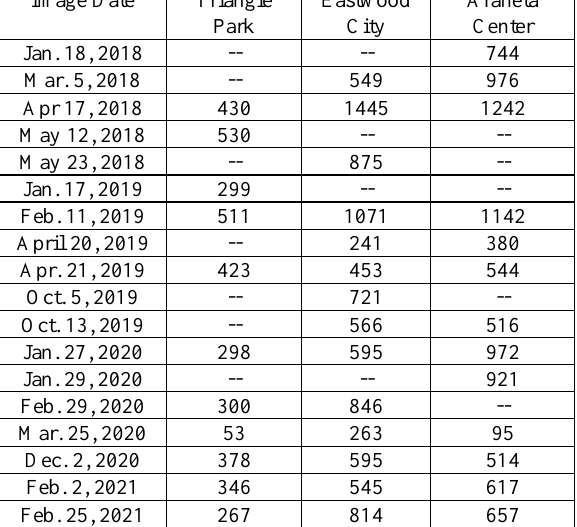
Table 3 . Total Vehicle count from 2018 to 2020 in the three sites